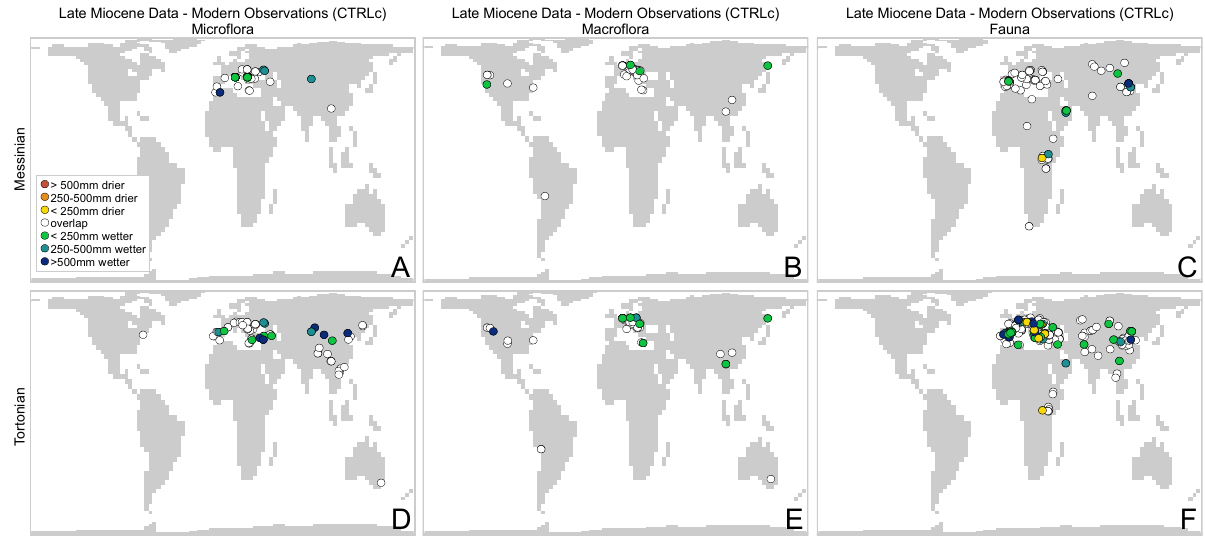
Fig. 11: Results from the model–data comparison for mean annual precipitation, late Miocene data–modern potential natural climate estimates.